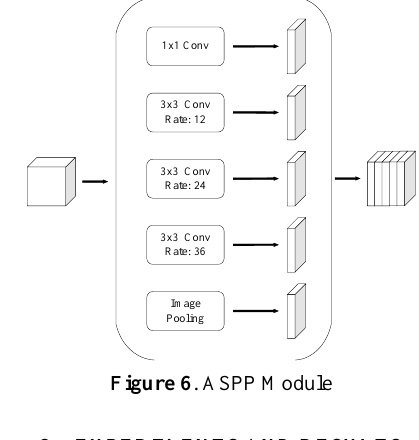
Figure 6 . ASPP Module